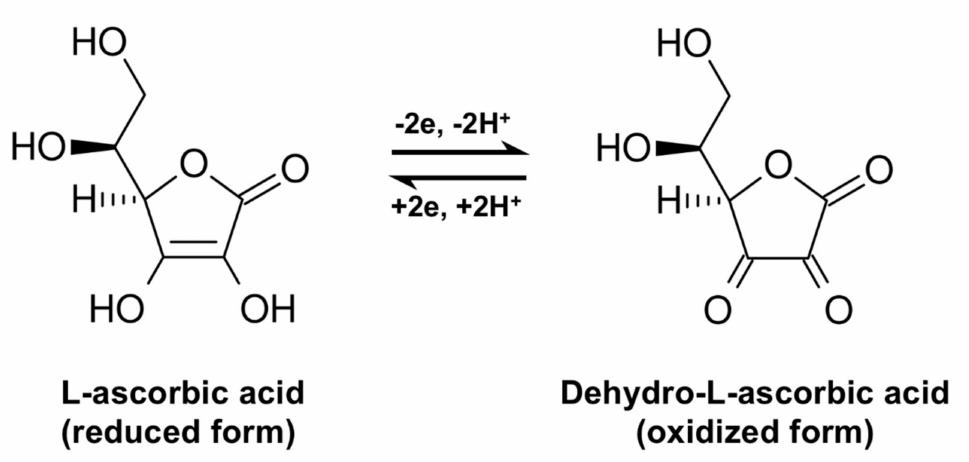
Figure 1. Reduced (left) and oxidized (right) forms of vitamin